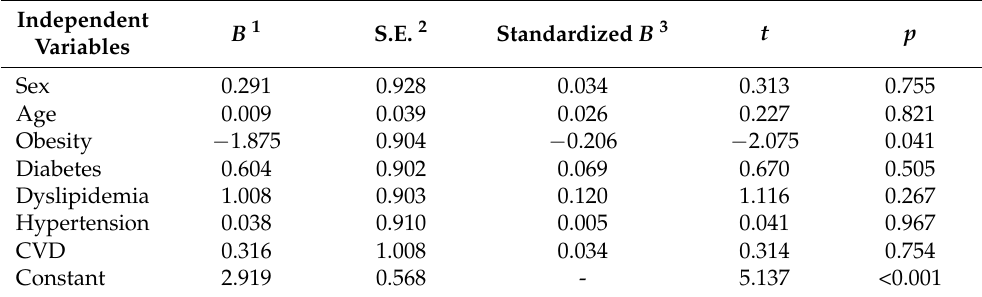
Table 5. Results of multilinear regression model ( stepwise ) that was designed using the number of days between the dates of hospitalization (inpatient admission) and ICU admission as the depen- dent variable.